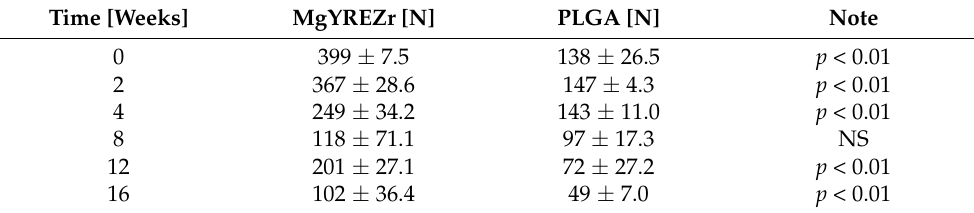
during the experiment. The photographs were not scaled; hence the different lengths in the picture. Asterisks indicate statistical significance in the pull-out force.